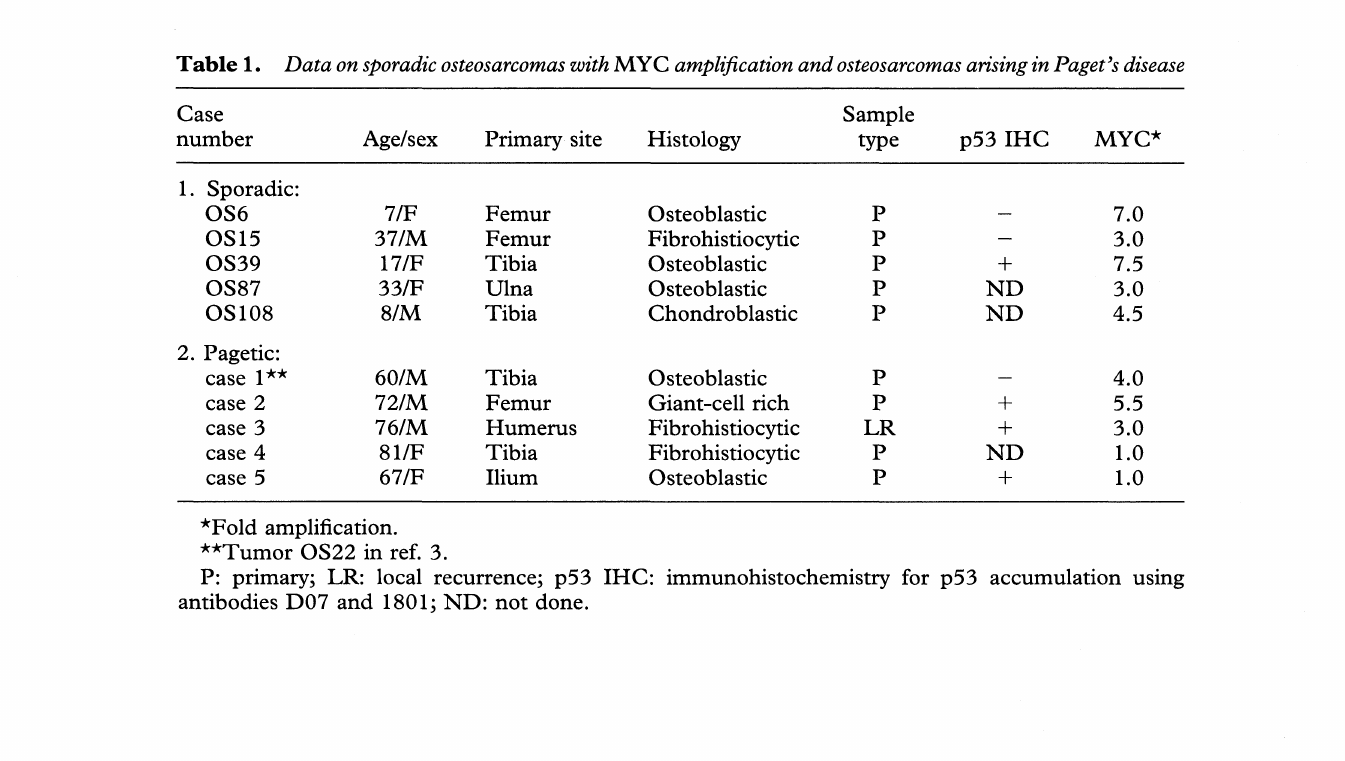
Table 1. Data on sporadic osteosarcomas with MYC amplification and osteosarcomas arising in Paget’s disease